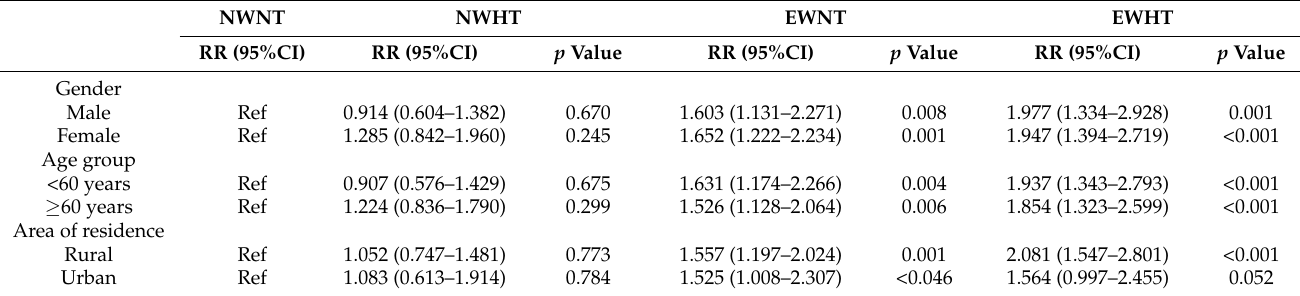
Table 3. Subgroup analysis on the associations between triglyceridemic-waist phenotypes and incident